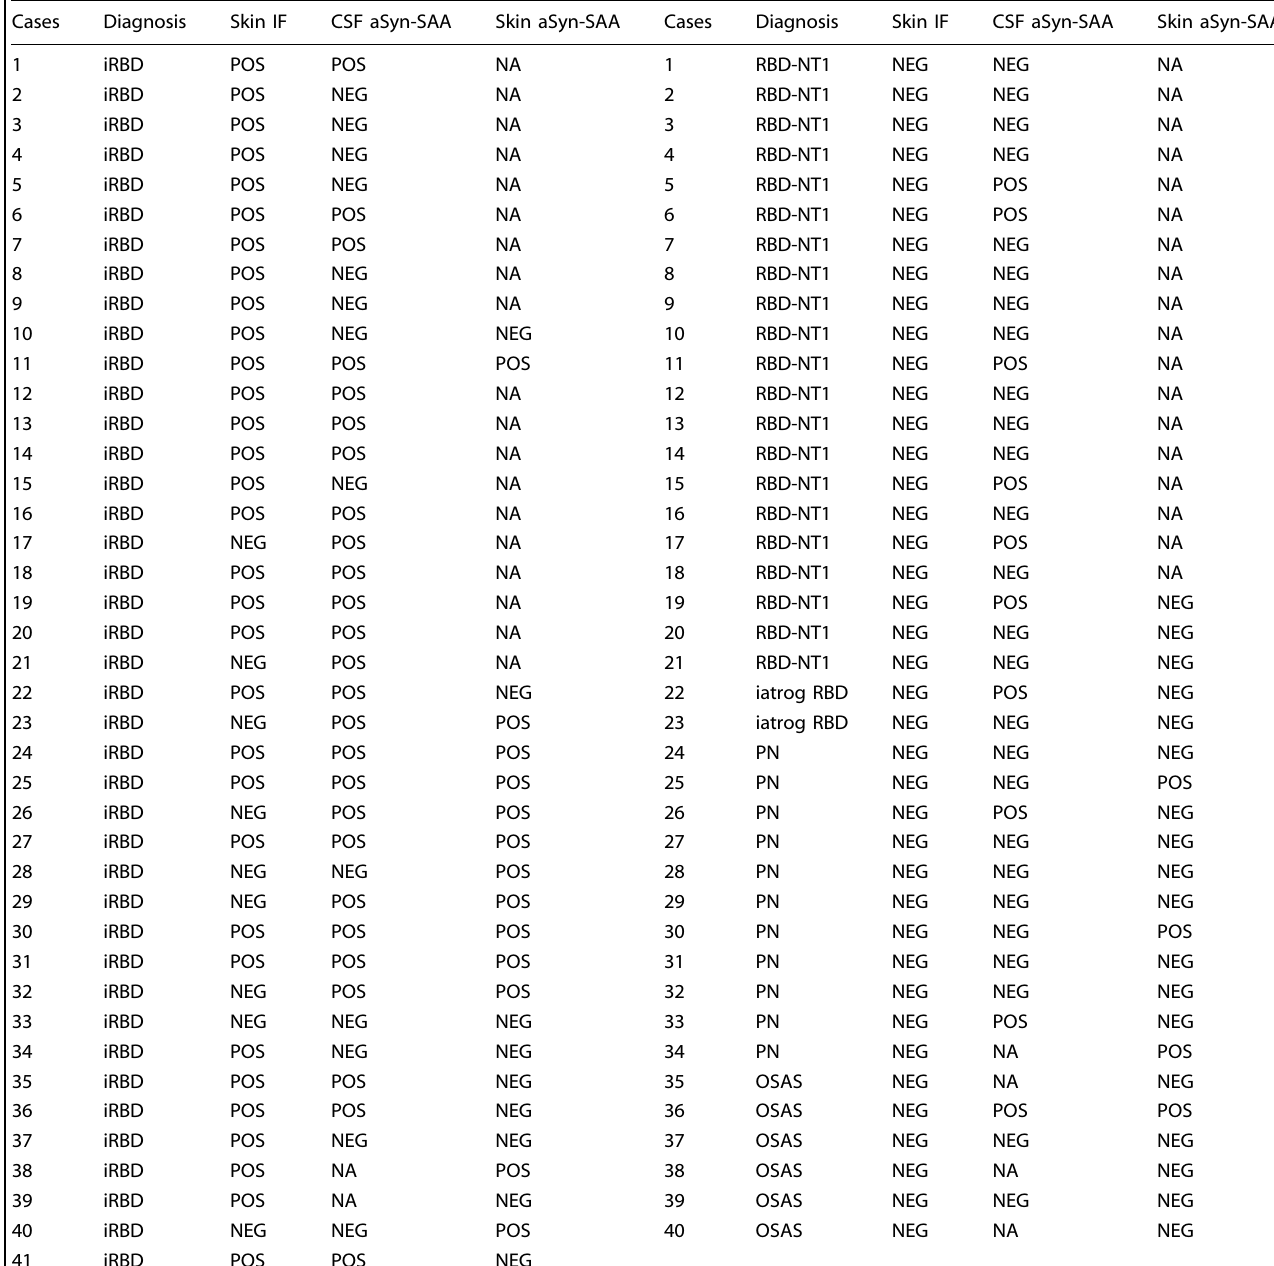
Table 3. IF and aSyn-SAA results in all recruited patients.